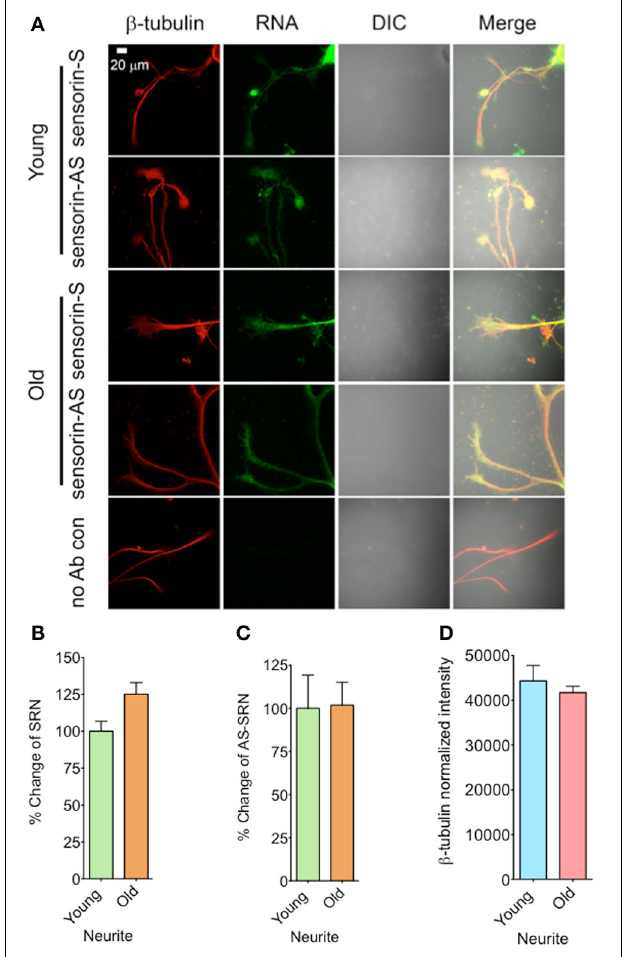
FIGURE 3 | Aging associated changes in expression of NAT-SRN in the neurites of Aplysia sensory neurons. (A) Confocal projection images of sensorin RNA (Green) co-stained with β -tubulin protein (Red), DIC and merged. (B,C) are the percentage changes of SRN and NAT-SRN distribution in the neurites of DIV4-cultured sensory neurons, respectively. (D) is the normalized intensity of β -tubulin protein distribution in young and old neurites. Image analyses were performed as described in Figure 2